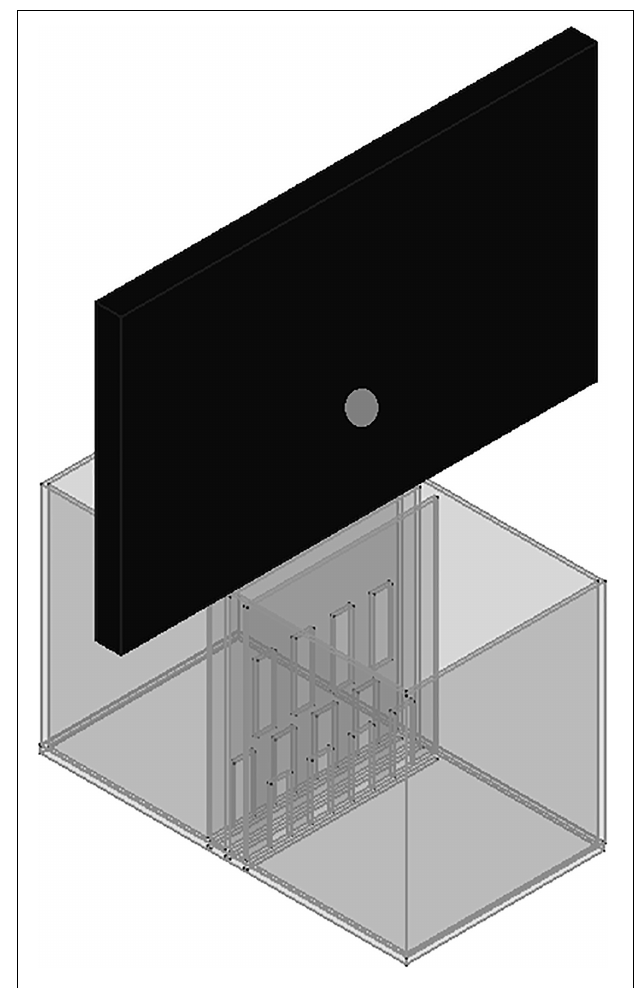
FIGURE 3 | A scheme to illustrate the proposed expansion of the VOC-NCE cage with an acoustic